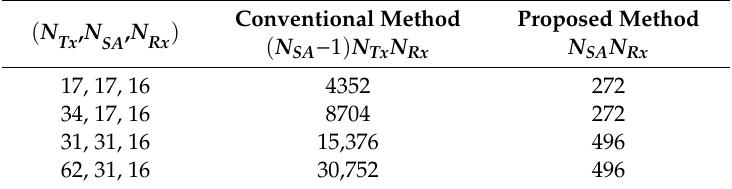
Table 2. Processing time (normalized by the sampling interval) required for beam training in the conventional and proposed